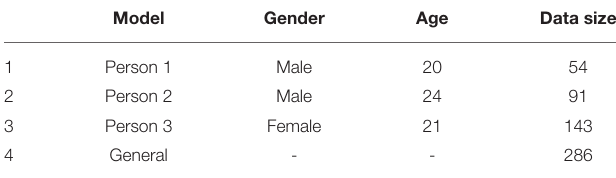
TABLE 3 | Occupants data description.